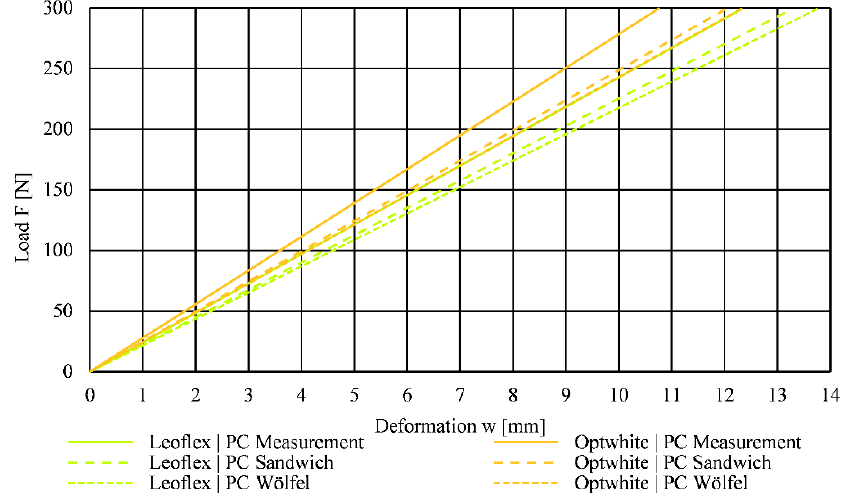
Fig. 7 Comparison of the measured values with the analytical solutions results by sandwich beam theory and extended theory of the approximate solution by